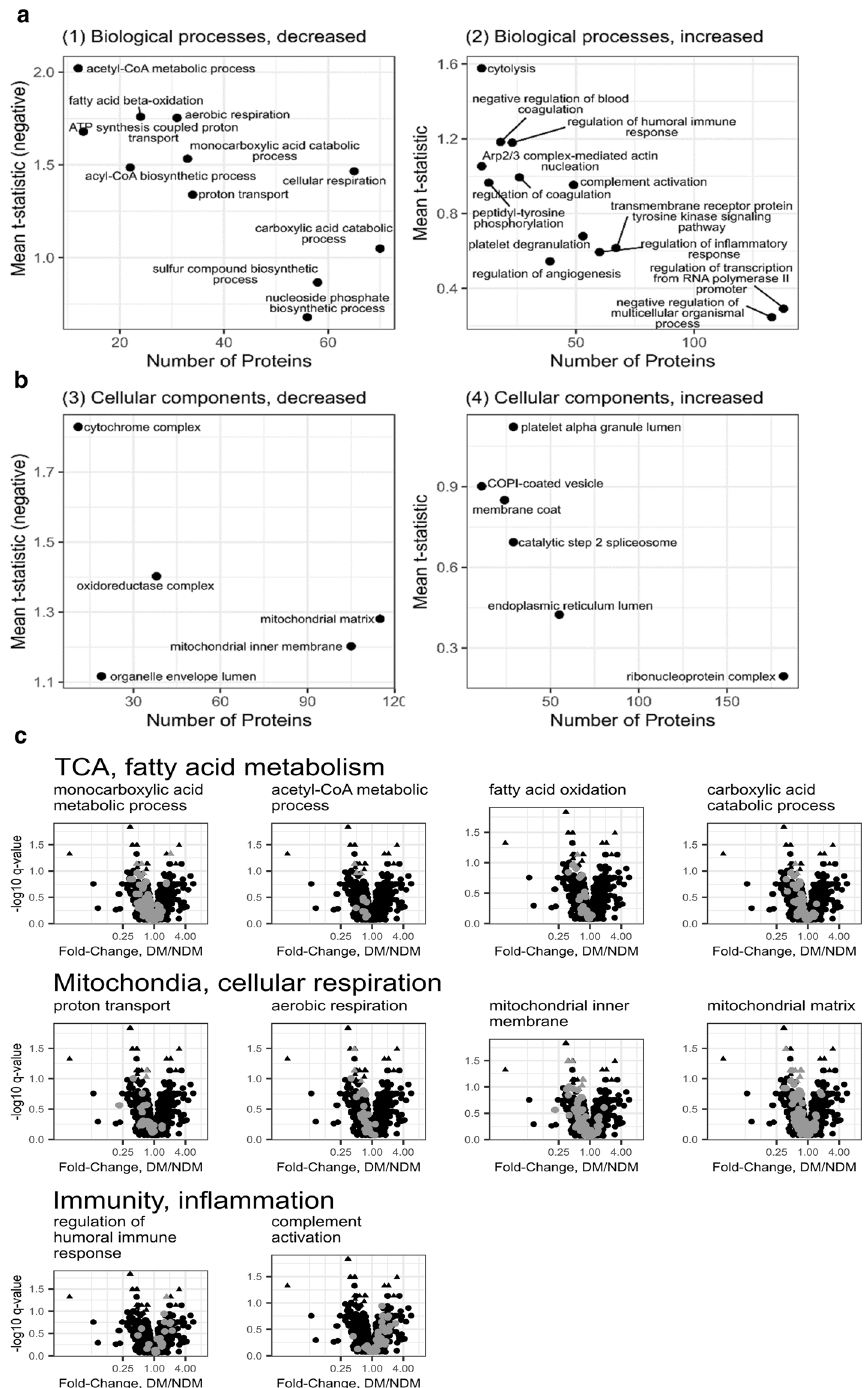
Figure 2. Protein categories of biological processes and cellular components affected by DM. Biological processes ( a ) and cellular components ( b ) decreased ( a1 , b3 ) or increased ( a2 , b4 ) in abundance in DM samples relative to NDM analyzed by PIANO (10% FDR). X-axis represents the number of proteins in each category; y-axis represents the value for a given category analyzed by enrichment test-statistic and related to mean of t-statistics for individual in-category proteins. Categories in lower right quadrants have multiple proteins with small abundance differences between DM and NDM groups, while categories in upper left quadrants have fewer proteins with larger abundance differences between DM and NDM groups. Categories displayed are a subset of all affected categories selected to minimize redundancy. ( c ) Differentially regulated pathways: Volcano plots of protein abundance for categories affected by DM. Protein abundance in categories related to TCA cycle, fatty acid metabolism, mitochondria, and cellular respiration were decreased, and immunity and inflammation proteins were increased in DM (PIANO, 10% FDR). Light grey points indicate proteins that are category members, triangles indicate proteins significantly regulated between DM and NDM (limma, q <